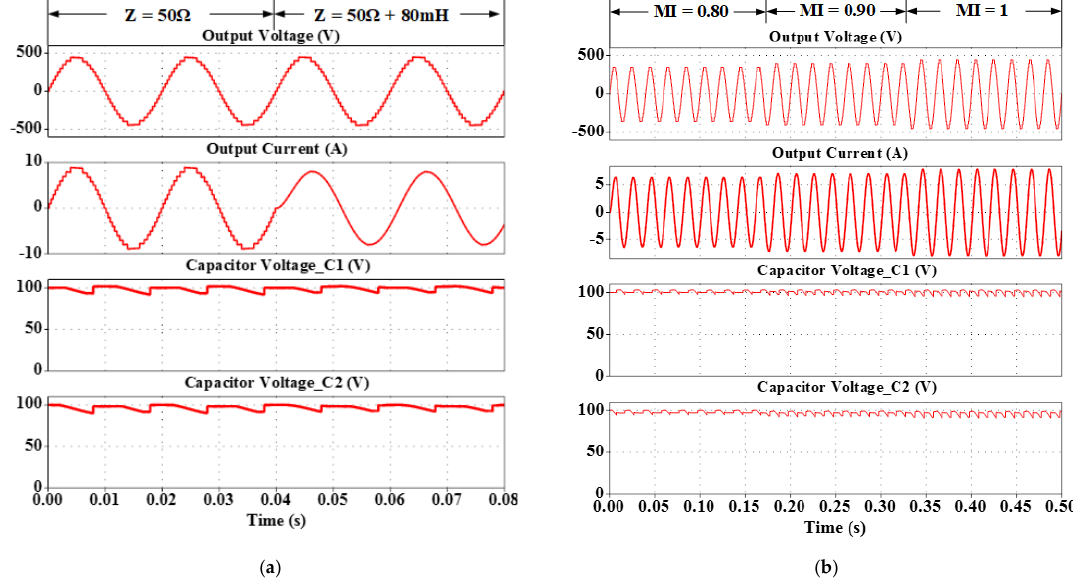
Figure 6. ( a ) Simulation results with load change ( b ) Simulation results with modulation index change.